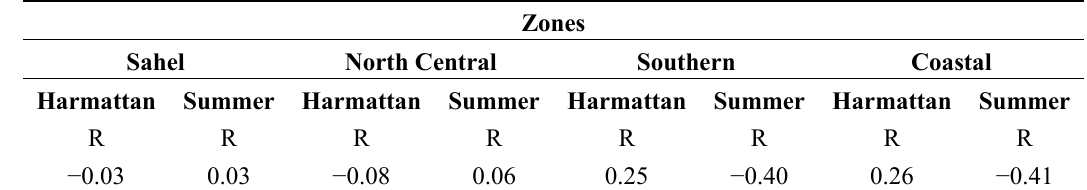
Table 3. Spear man correlation coefficients between visibility and relative humidity for the four zones of Nigeria.